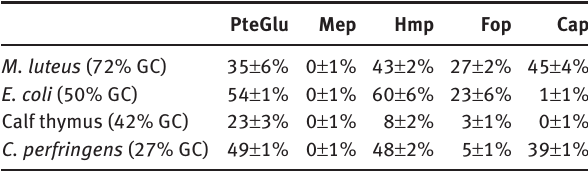
Table 3 Percent of sensitizer bound to DNA after 24 h equilibrium.